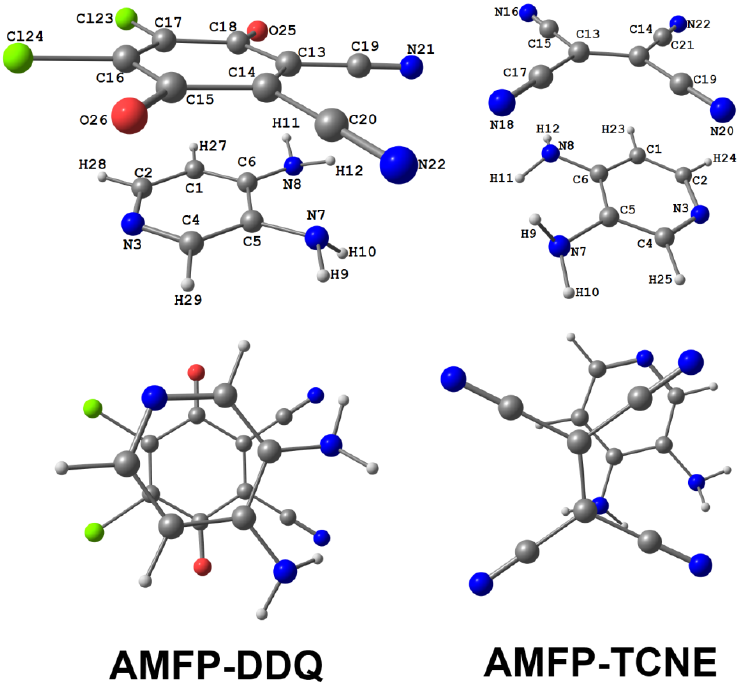
Figure 12. The atom numbering ( upper ) and the view showing the overlay between the donor and